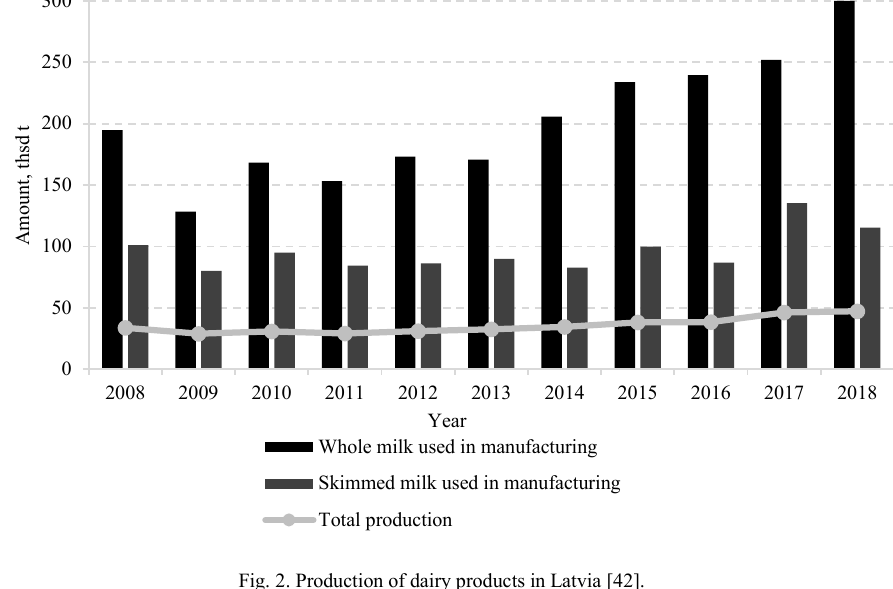
Fig. 2. Production of dairy products in Latvia